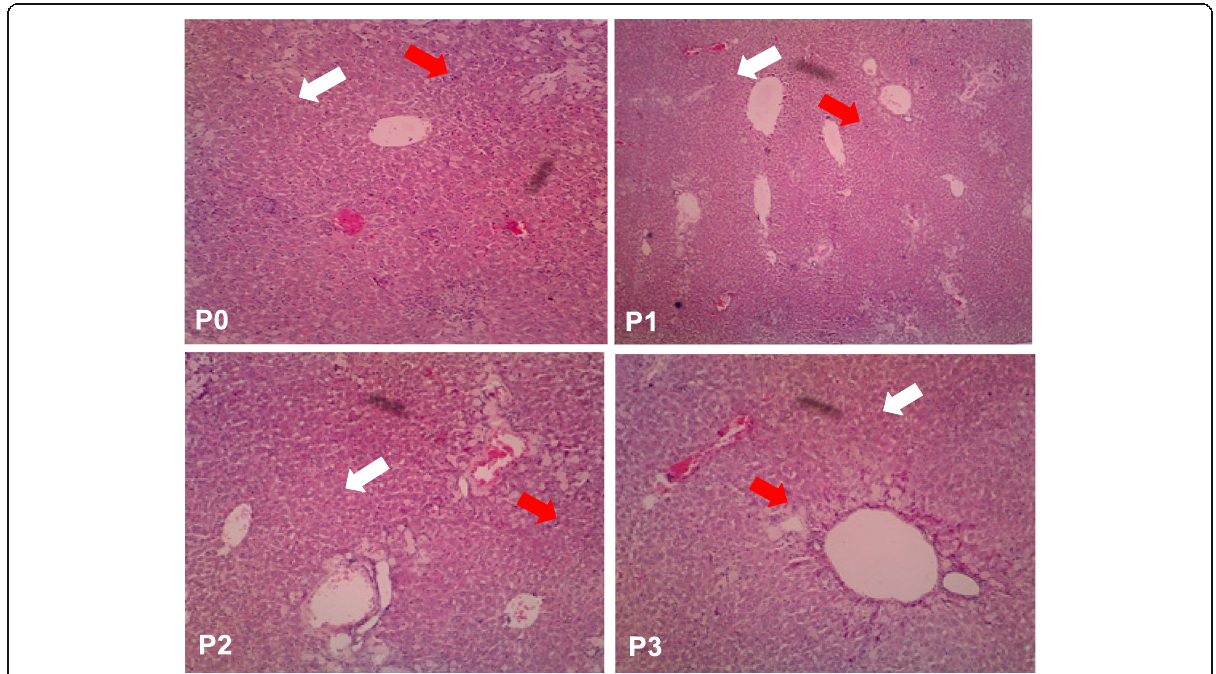
Fig. 5 Histology description of liver in the rats given the ethyl acetate fraction of the Malaka flesh. White arrow = hepatocyte, red arrow =